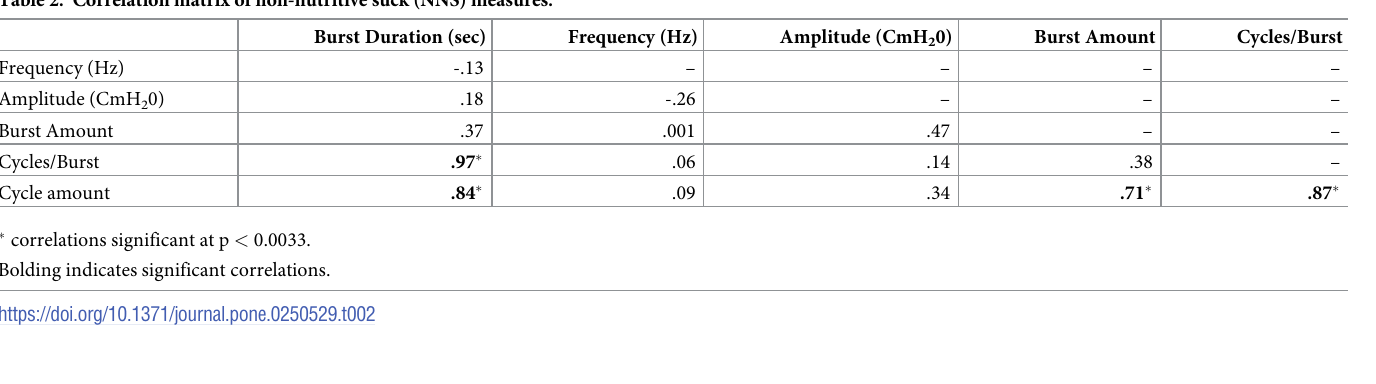
Table 2. Correlation matrix of non-nutritive suck (NNS)